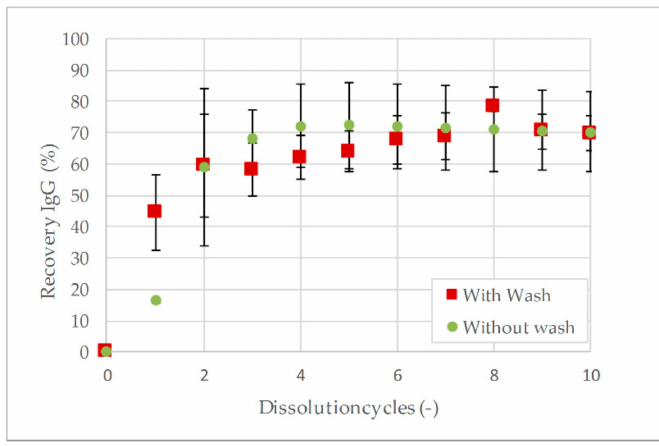
Figure 18. Feasibility study of dissolution of mAb after precipitation from LP (light phase) using PBS (phosphate-bu ff ered saline) bu ff er (pH 7.4) and the experimental set-up shown above. Error bars depict the double determination of product recovery. IgG (Immunoglobulin